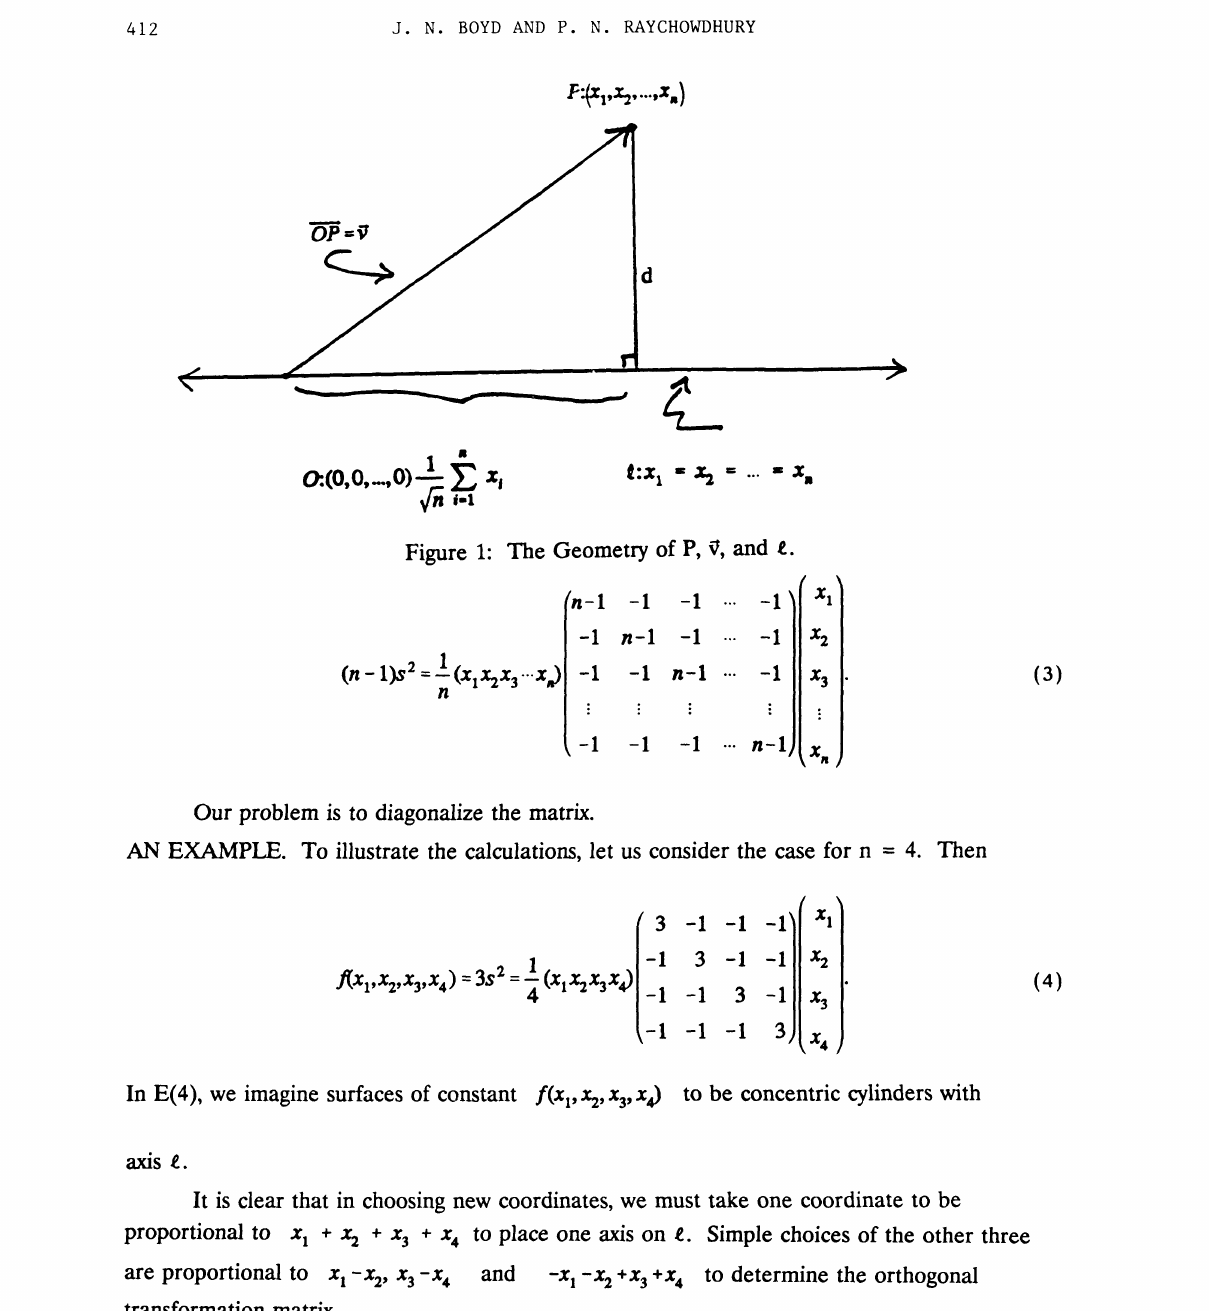
Figure 1: The Geometry of P, 7, and